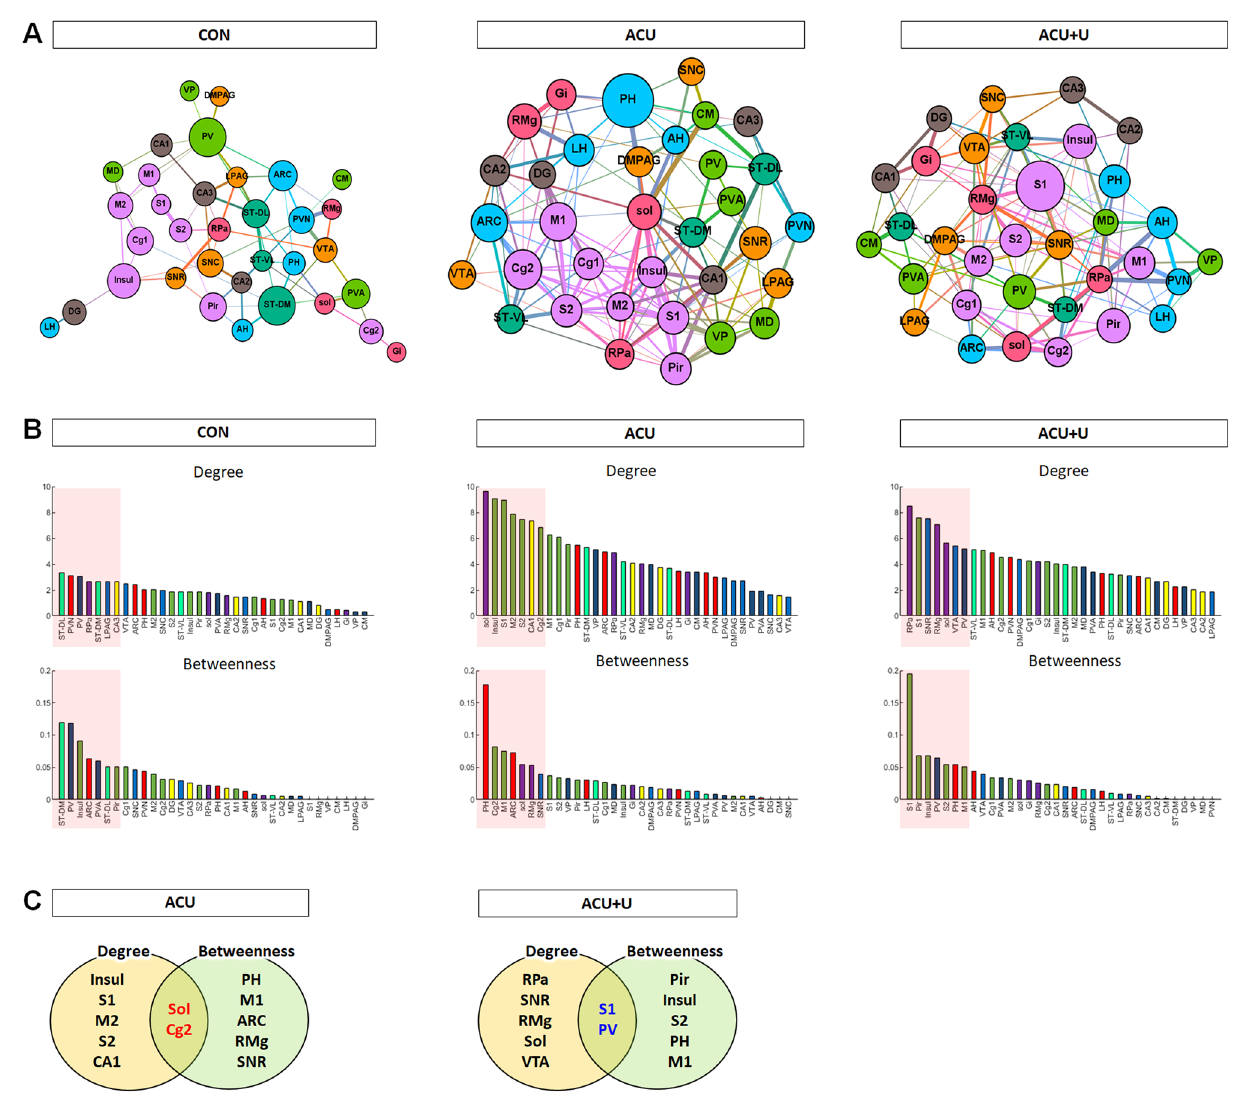
Figure 6. Network clustering and hub-identification. ( A ) A force atlas format to show the degree and betweenness centrality. The number of edges was represented as degree, and the number of shortest paths of all possible pairs of nodes represented betweenness centrality. ( B ) Brain regions were ranked in descending order for degree and betweenness centrality of the CON, ACU, and ACU + U groups. Brain regions ranked above the 80th percentile for degree and betweenness centrality were indicated by a red-coloured box. ( C ) Venn diagram shows the overlap between brain regions ranked above the 80th percentile for degree and betweenness centrality in the ACU and ACU + U groups. Two putative hub regions (Sol and Cg2 in the ACU group; S1 and PV in the ACU + U group) were identified as hub brain regions in each group. CON control, ACU acupuncture treatment, ACU + U U0126 administration followed by acupuncture treatment. Abbreviations for each brain region are shown in Table